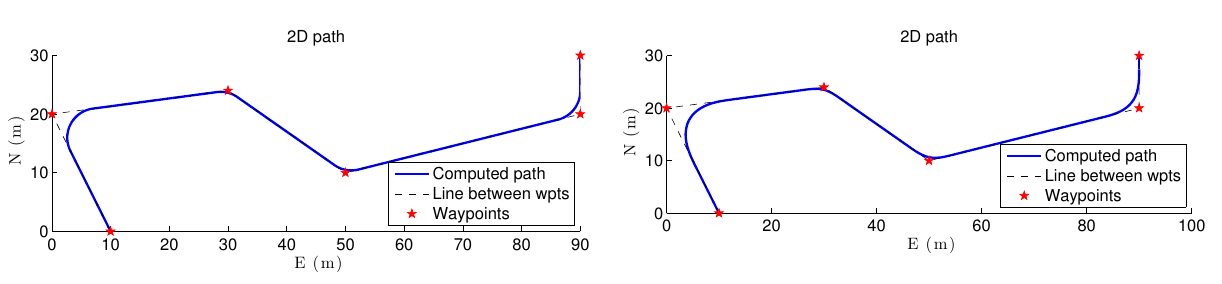
Figure 3: Circular smoothing path